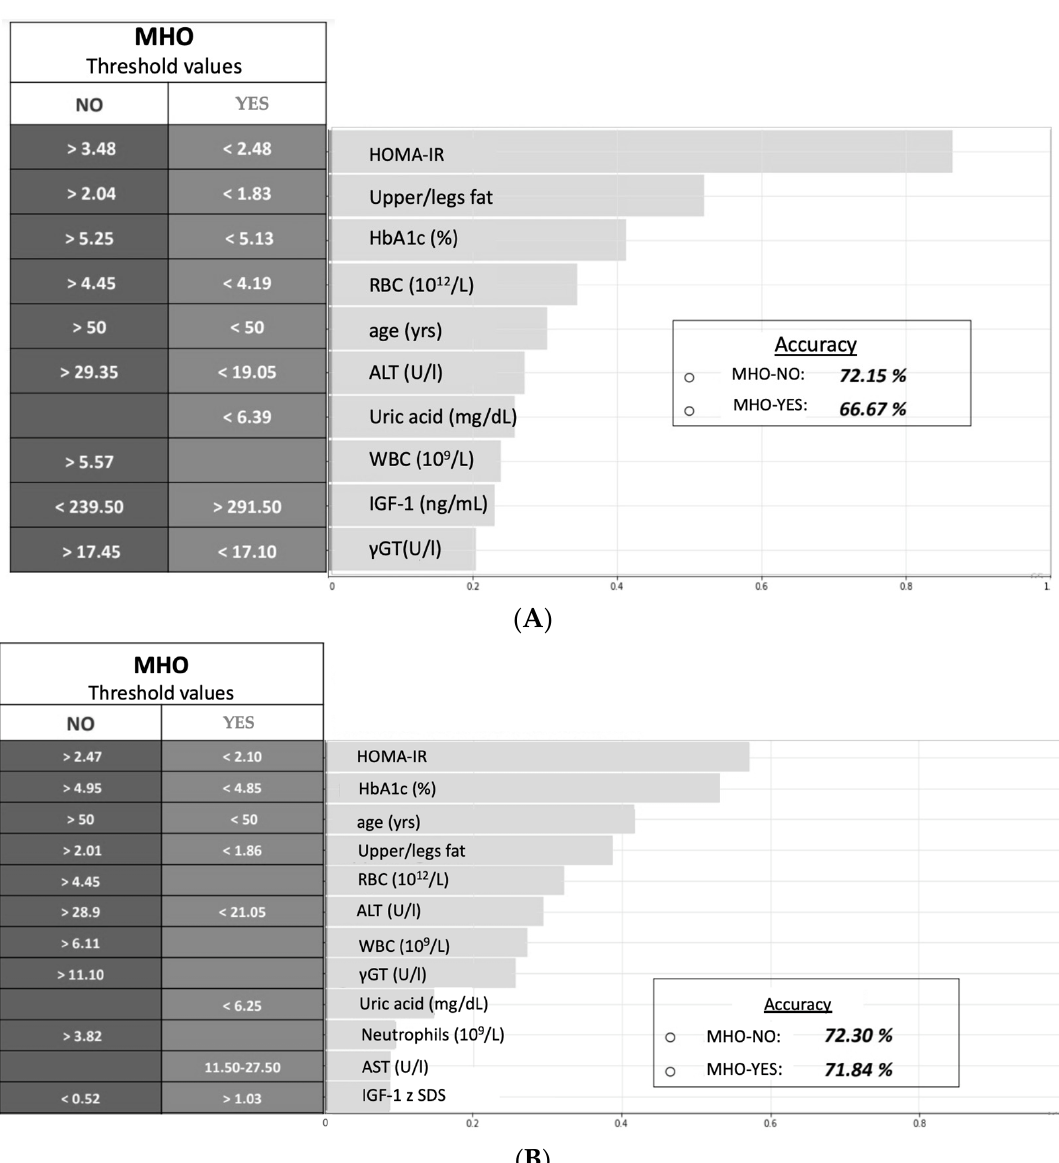
Figure 2. ( A ) Model no. 1 with the most relevant variables and threshold values that predict the development of MUO. ( B ) Model no. 2 with the most relevant variables and threshold values that predict the development of MUO. Abbreviations: yrs, years; HOMA-IR, model assessment of insulin resistance; HbA1c, haemoglobin A1C; RBC, red blood cell; ALT, alanine aminotransferase; WBC, white blood cell; γ GT, gamma-glutamyl transferase; AST, aspartate aminotransferase, IGF-1 zSDS, insulin-like growth factor 1 z standard deviation score; MUO, metabolically unhealthy obese group; MHO, metabolically healthy obese group. IGF-1, insulin-like growth factor 1 .